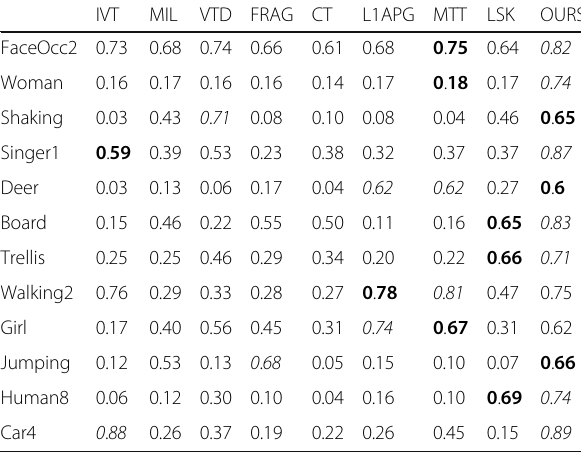
Table 3 Success rate. The best and second best results are shown in italic and bold